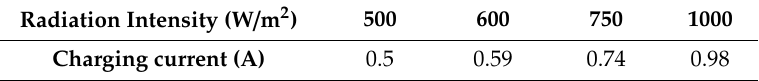
Table 2. Values of charging current along with increased radiation